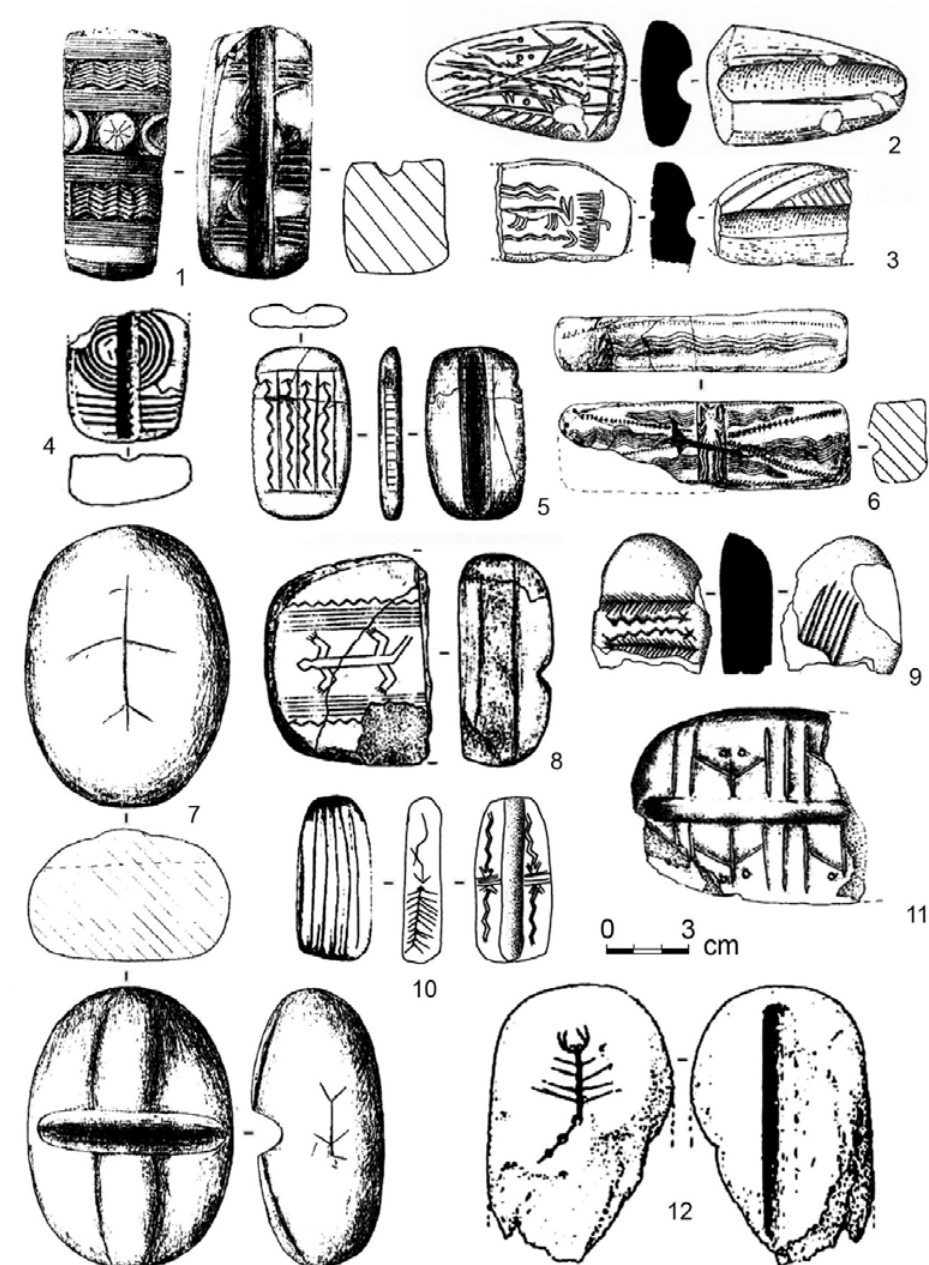
Figure 4. Grooved stones from “The Golden Triangle” (Upper Mesopotamia). 1, 5-11: Tell Qaramel (Mazurowski & Kanjou 2012: fig. 68, 2, 4; 69, 3; 70, 3; 71, 372, 2; 75, 1; 79, 5); 2-4, 12: Jerf el Ahmar (Benz & Bauer 2013: fig. 4, 6, 8, 10,